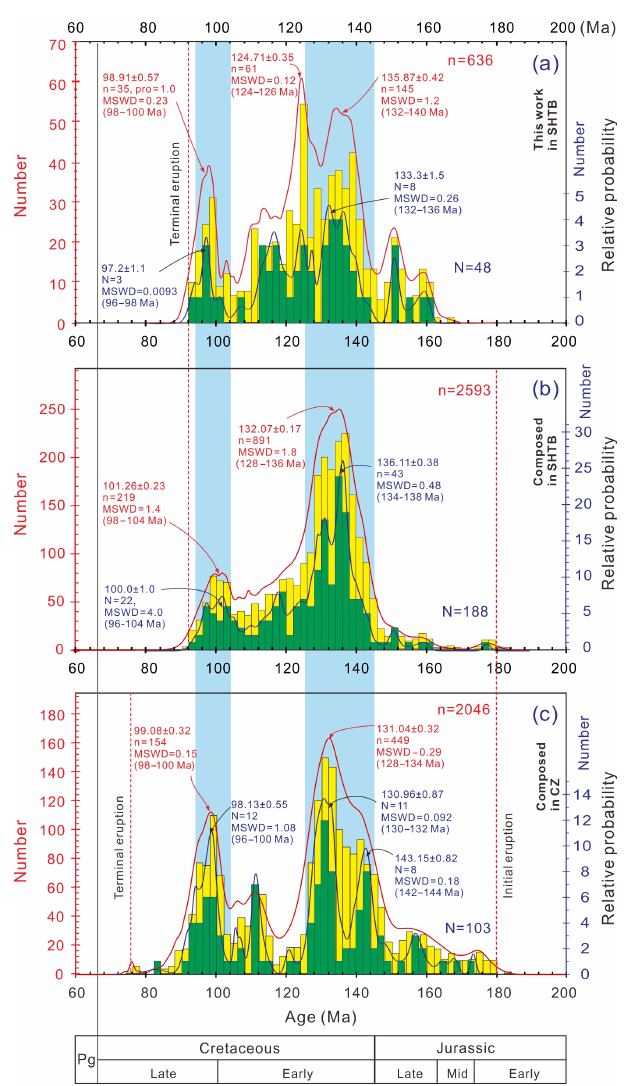
Figure 2. Relative probability and histogram diagrams of concor- dant zircon U–Pb isotope and sample weighted-mean ages of extru- sive rocks from SE China (for details, see Tables S1, S2, and S3). (a) This study in SHTB; (b) this and previous studies combined in SHTB; (c) published data in CZ. N : number of rock samples; n : total number of zircon grains.